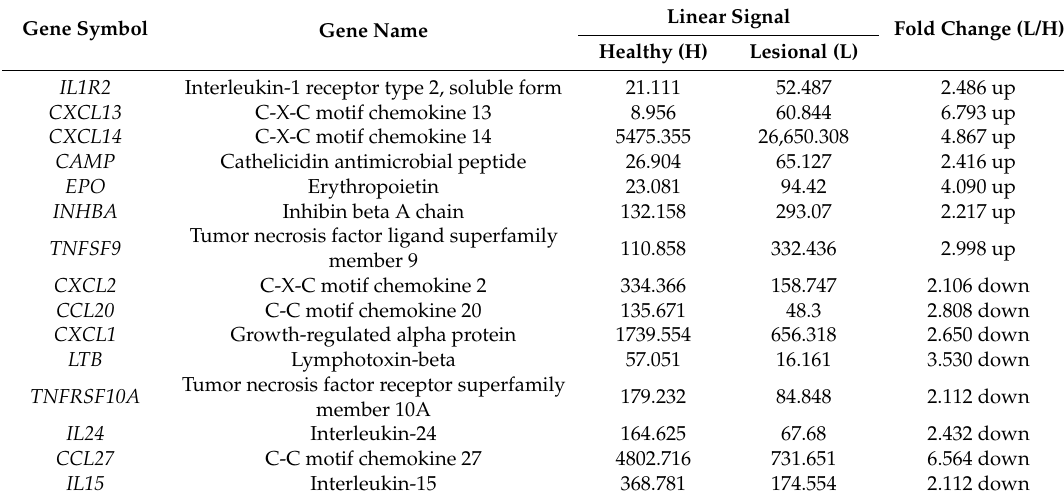
Table 1. Deregulated cytokines and growth